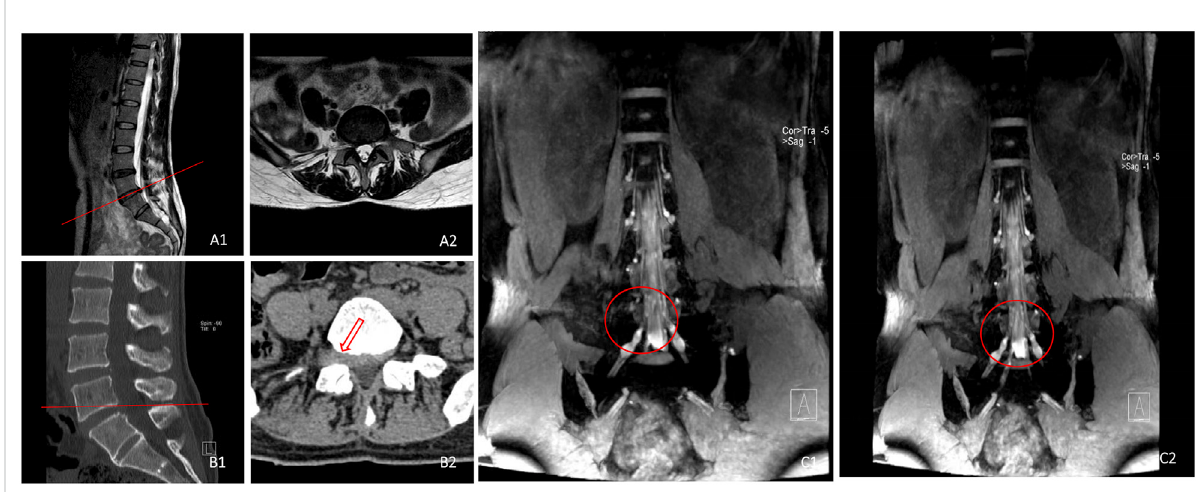
FIGURE 5 Sagittal (A1) and cross-sectional (A2) MR images indicated that the right side of L4/L5 intervertebral disc protruded, Sagittal (B1) and cross- sectional (B2) CT images displayed that the extreme lateral side of L4/L5 segment protruded greatly, and 3D-DESS image (C1, C2) revealed that the right L5 nerve root was compressed in the spinal canal, and the walking was interrupted. The protruded intervertebral discs on the extreme lateral side did not compress L4 nerve root, with smooth walking.